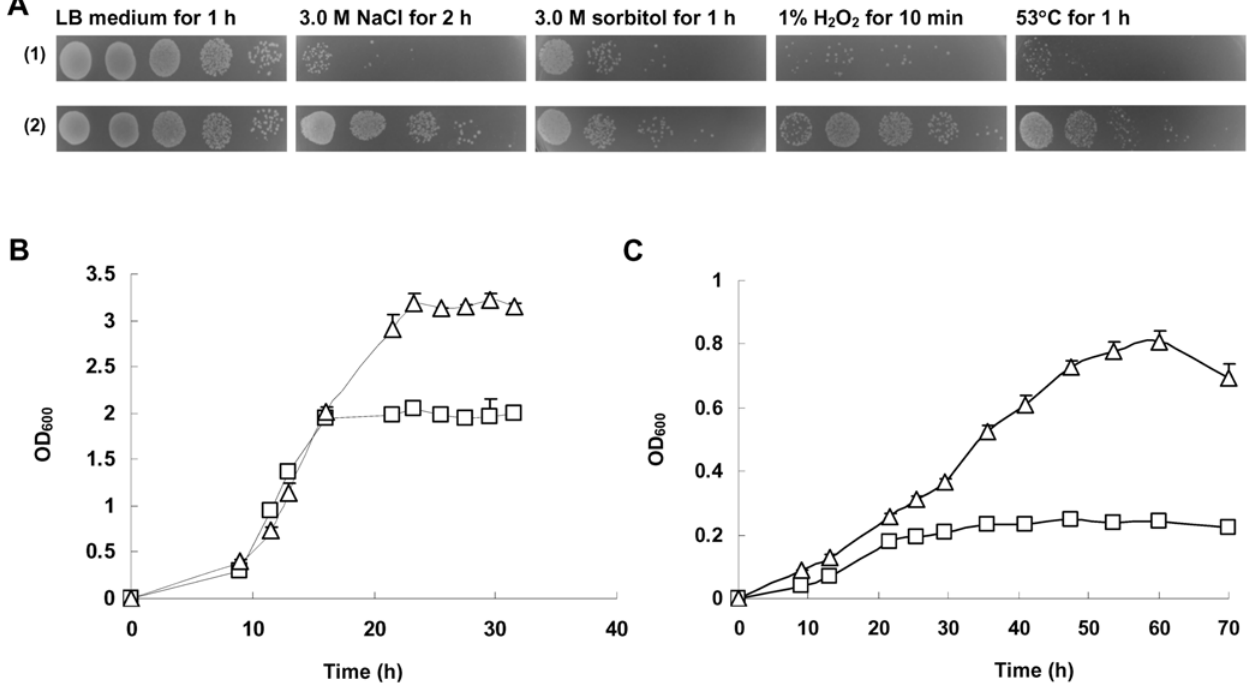
Figure 1. Effects of abiotic stresses on growth of E.coli strains. A : Growth of the E. coli control strain carrying only the pMG1 vector (1) and the transformant strain expressing IrrE (2) in LB medium after exposure to various abiotic stresses; B : Growth of the control strain (squares) and the IrrE-expressing strain (triangles) in M9 minimal medium; C : Growth of the control strain and the IrrE-expressing strain in M9 minimal medium containing 0.65 M NaCl.